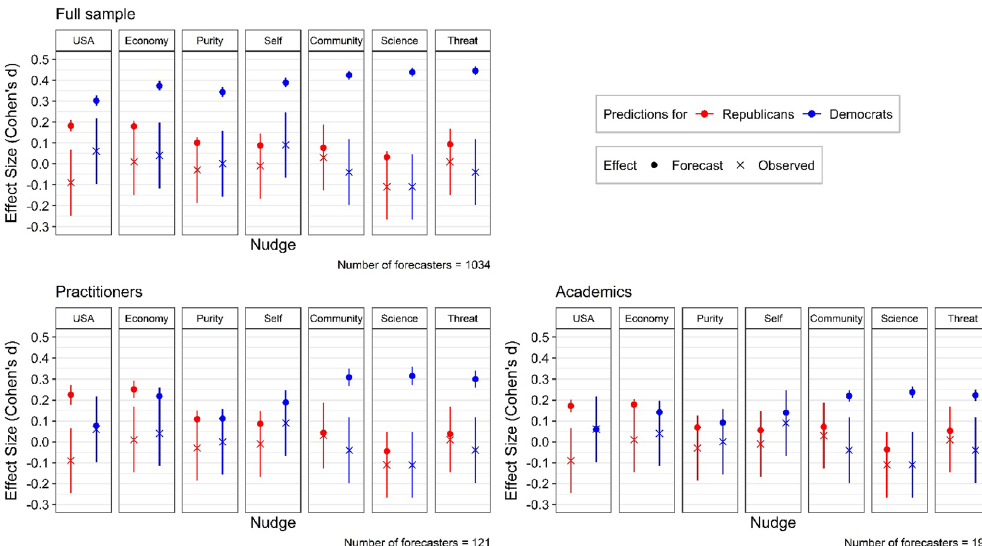
Figure 2. Forecasted and observed effects by nudge conditions and political party of nudgee. Note : Predicted (dot) and observed (cross) effect sizes (Cohen’s d) for the seven nudge predictions, differentiated by color for forecasts regarding Republican (red) and Democrat (blue) nudgees. The top panel includes the full sample of forecasters while the bottom panel shows effect sizes separately for academic and practitioner forecasters. Error bars represent the 95% confidence interval. “USA” indicates the “Patriotic duty” nudge; “Economy” indicates the “Reviving the Economy” nudge; “Self” indicates the “Protection from Harm (Self)” nudge; “Community” indicates the “Protection from Harm (Community)” nudge; “Science” indicates the “Scientific evidence”